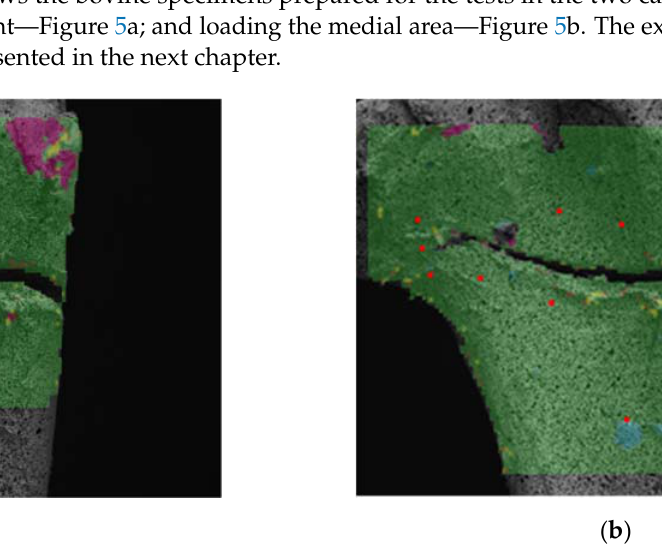
Figure 5. Test specimens prepared for the determination of displacements and strains occurred during offset loading (Fujisawa point) ( a ) and medial loading ( b ).